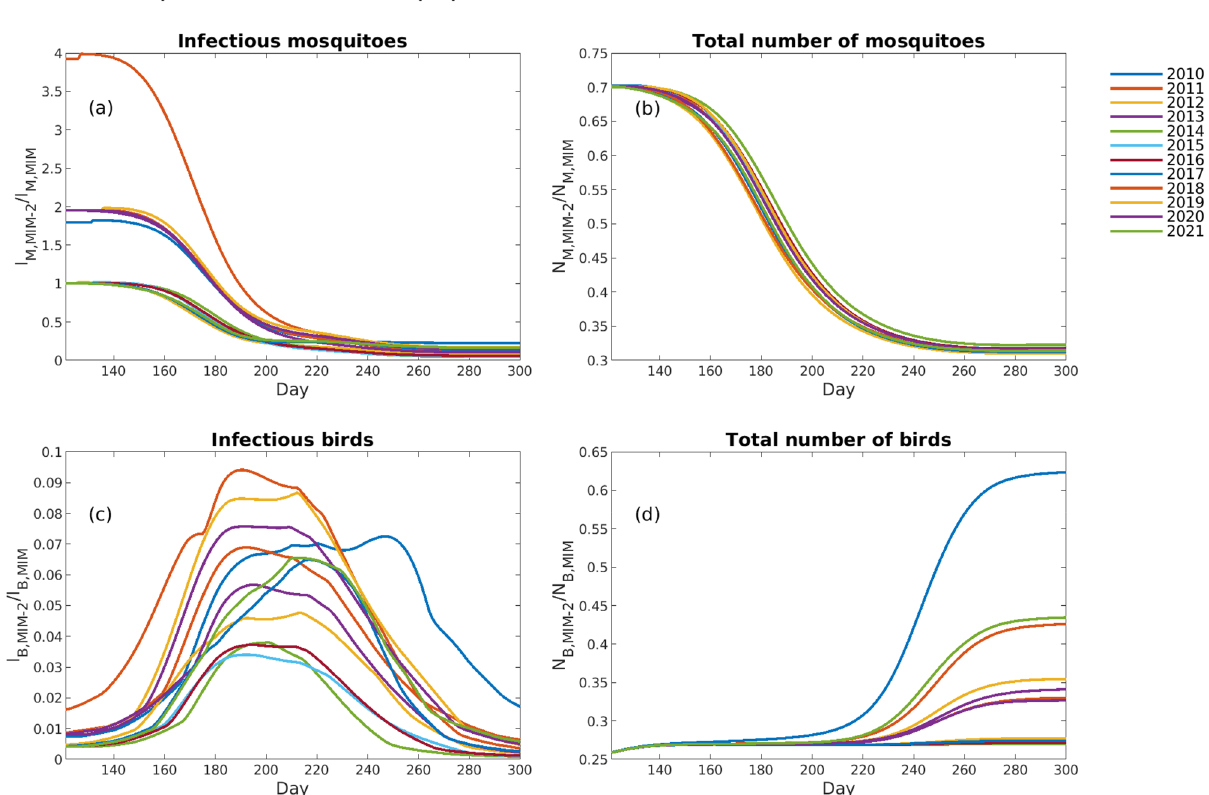
Figure 6. The temporal evolution during May to October of ( a ) the ratio between the number of WNV-infected mosquitoes modelled by MIMESIS-2 ( I M , MIM − 2 ) and the ratio modelled by MIMESIS ( I M , MIM ), ( b ) the ratio between the total number of mosquitoes modelled by MIMESIS-2 ( N M , MIM − 2 ) and the ratio modelled by MIMESIS ( N M , MIM ) , ( c ) the ratio between the number of infected birds modelled by MIMESIS-2 ( I B , MIM − 2 ) and the ratio modelled by MIMESIS ( I B , MIM ) , and ( d ) the ratio between the total number of birds modelled by MIMESIS-2 ( N B , MIM − 2 ) and the ratio modelled by MIMESIS ( N B , MIM ) for each of the years from 2010 to 2021. The plots refer to the simulations for the municipality of